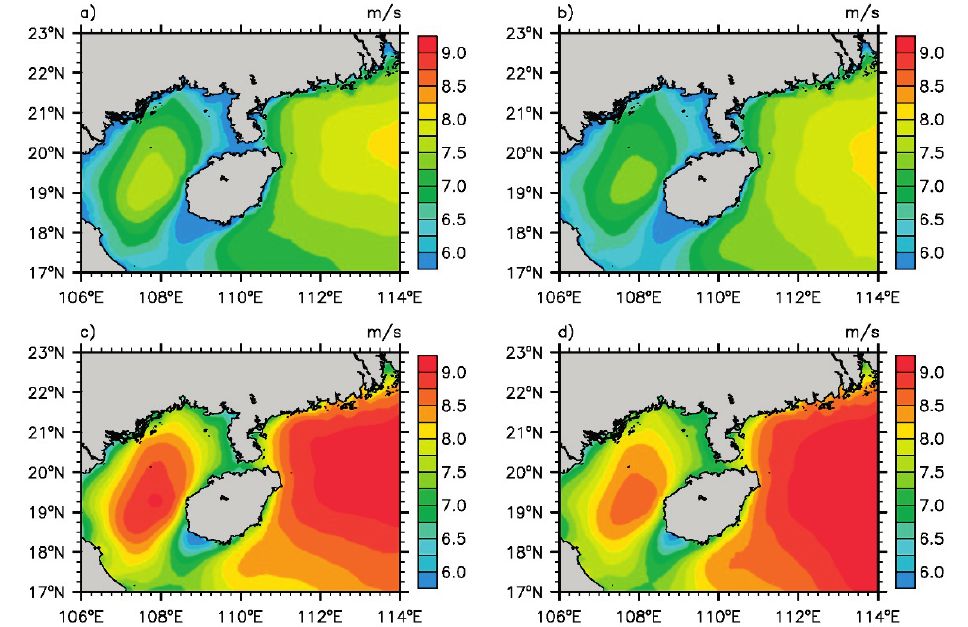
Figure 9. Maps of the mean wind speed at 10 m and 100 m from control run and assimilation run averaged with co-located samples: ( a ) wind speed at 10 m from control run, ( b ) wind speed at 10 m from assimilation run; ( c ) wind speed at 100 m from control run and ( d ) wind speed at 100 m from assimilation